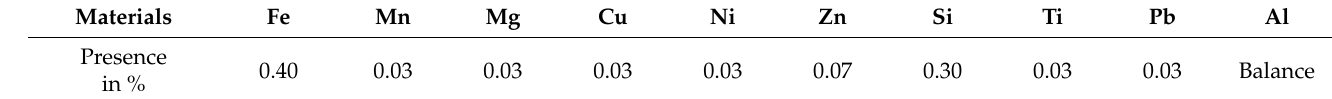
Table 1. Chemical composition of commercially available pure aluminum (LM0).